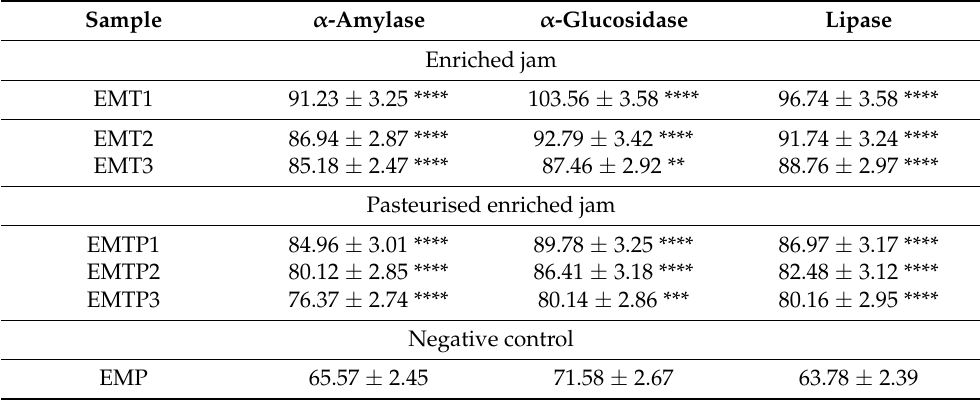
Table 8. Hypoglycaemic and hypolipidemic activity (%) of